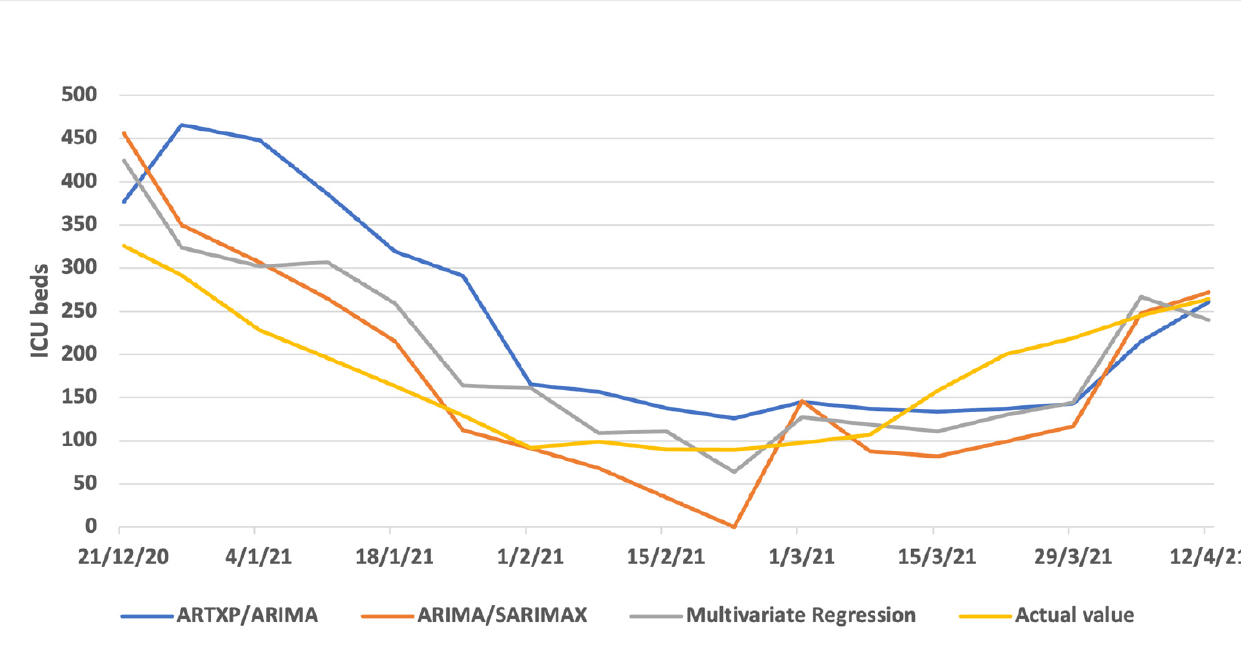
Figure A6. Three weeks Predicted vs. Actual ICUs—Northern Greece. Figure A7 (one week ahead), Figure A8 (two weeks ahead) and Figure A9 (three weeks ahead) showcase the results per model (ARTXP/ARIMA, ARIMA/SARIMAX and Multivariate Regression) of Predicted vs. Actual ICUs for the Greece